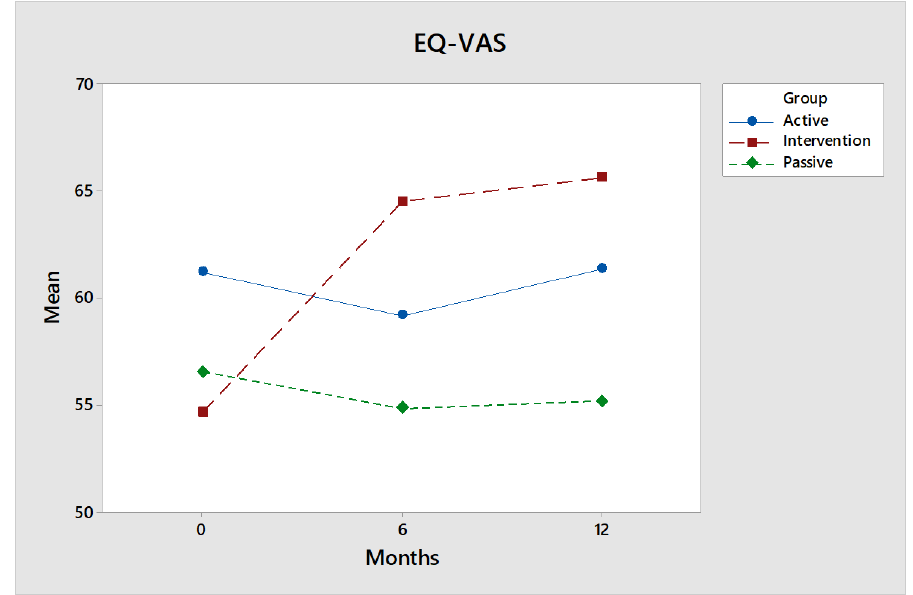
Figure 8. EQ-VAS is a global measure of self-estimated health, where 0 = worst possible health and 100 = best possible health. The average of the intervention group (red) rises significantly over time, while the control groups (green and blue) do not change over time.